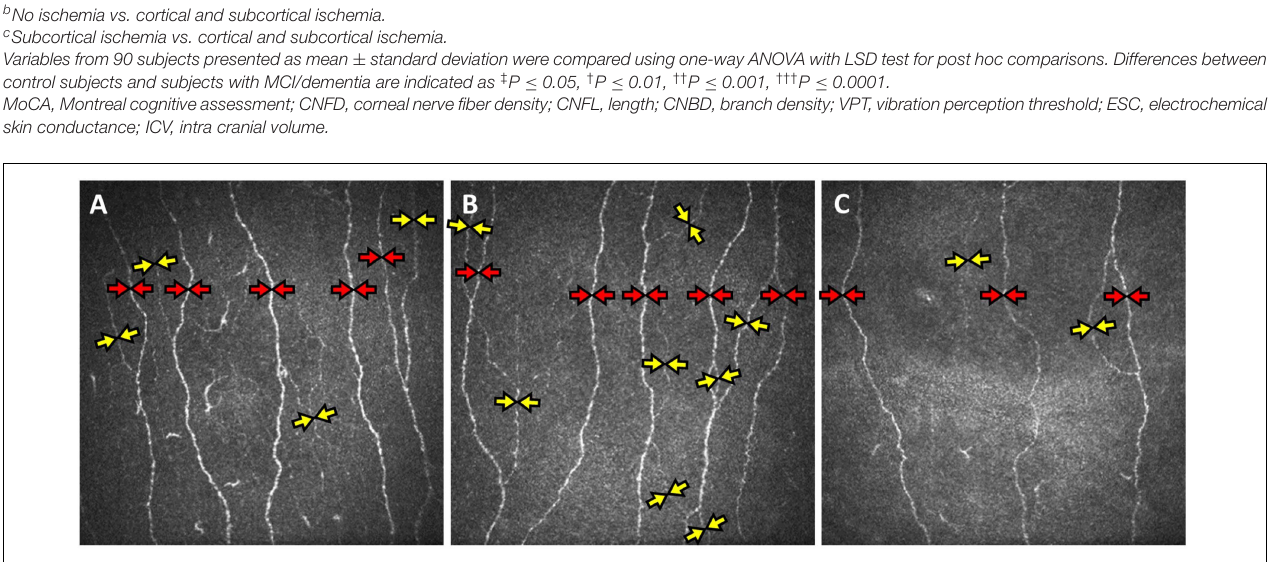
FIGURE 1 | Corneal confocal microscopy (CCM) images of the sub-basal nerve plexus of subjects with mild cognitive impairment without cerebral ischemia (A) , with subcortical ischemia (B) , and cortical and subcortical ischemia (C) showing reduced main nerve fibers (red arrows), branches (yellow arrows) and total fiber length in subjects with cortical and subcortical